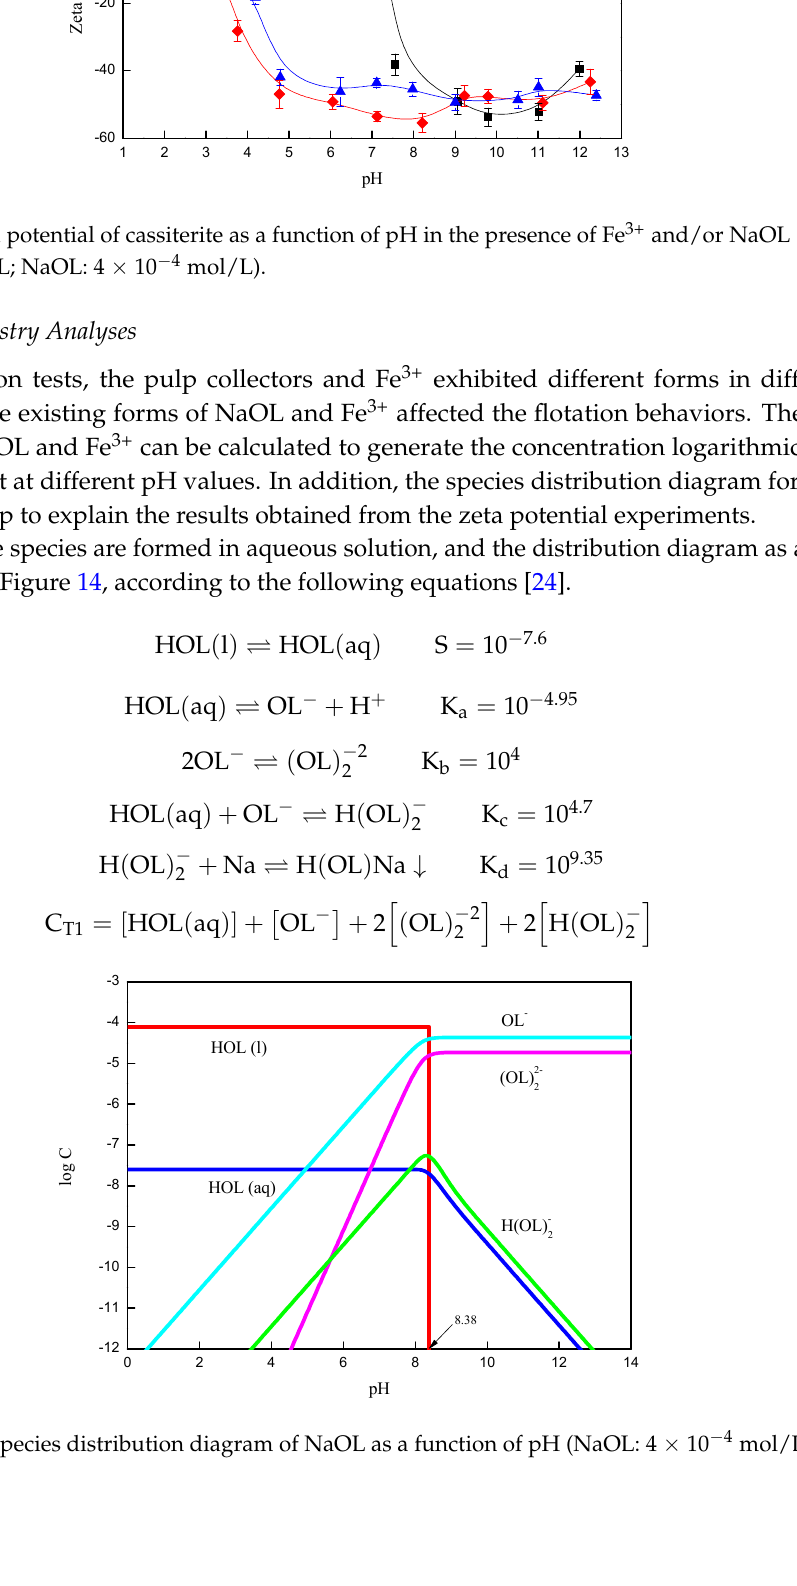
Figure 14. Species distribution diagram of NaOL as a function of pH (NaOL: 4 × 10 − 4 mol/L).